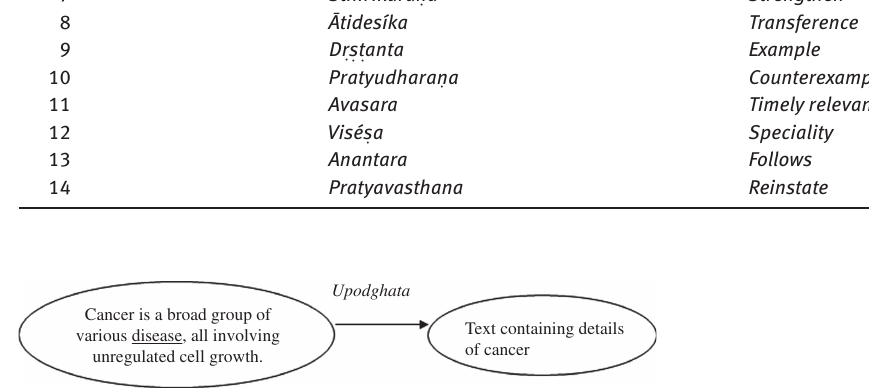
Figure 2. Usage of Upodghāta Sangati